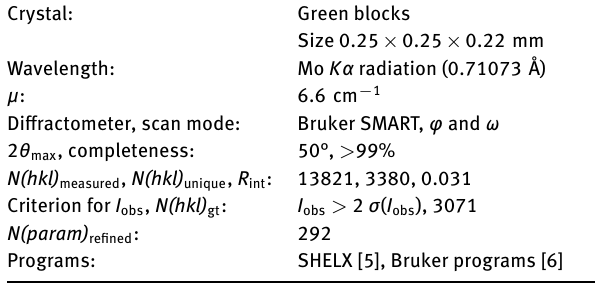
Table 1: Data collection and